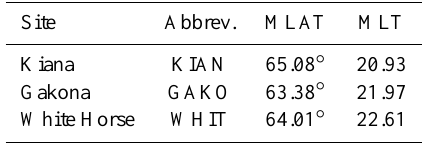
Table 1. Locations of the THEMIS All-Sky-Imager sites used for the 21 December 2006 substorm event study. Site Abbrev.